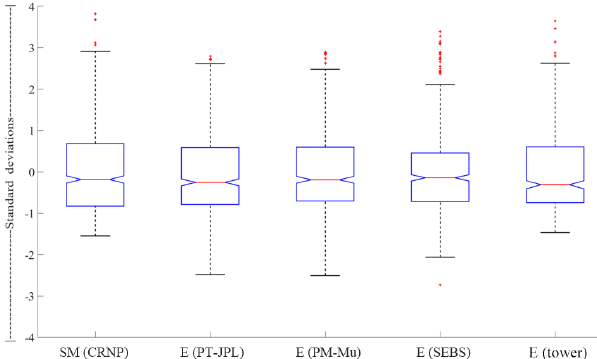
Figure 5. ANOVA boxplots of standardized CRNP soil moisture, and standardized evaporation estimates and observations for the en- tire time